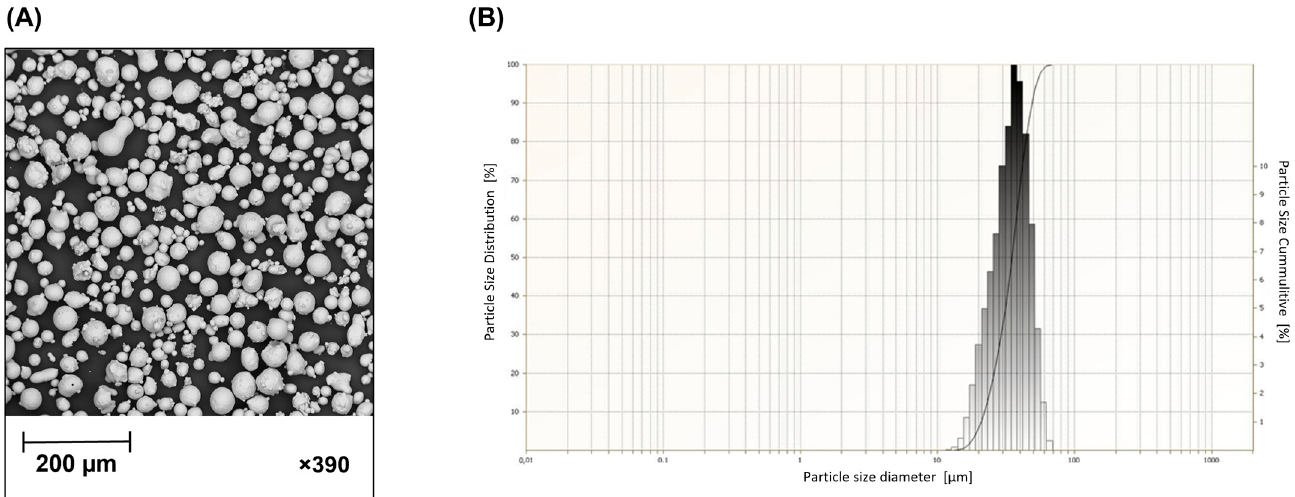
Figure 3. MetcoAdd TM 316L-A powder characterization: ( A ) SEM morphology, ( B ) particle size distribution analysis.